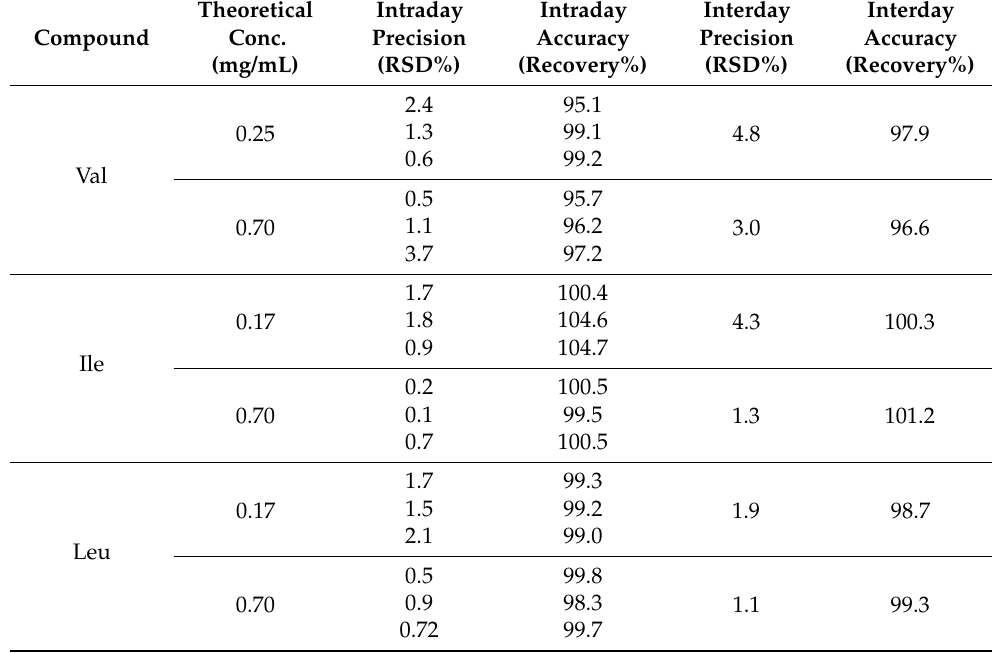
Table 2. Intraday and interday RSD% and recovery%